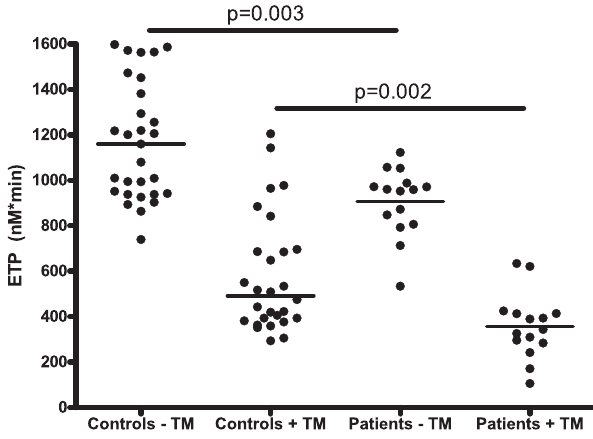
Figure 2. Endogenous Thrombin Potential (ETP) in plasma from patients and healthy controls in absence and presence of thrombomodulin (TM). Horizontal bars indicate